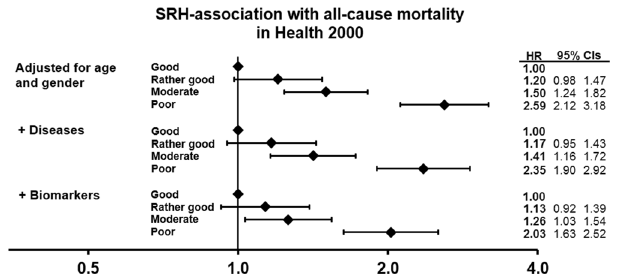
Figure 3. Association of self-rated health with mortality in the Health 2000 data (n = 5,957; deceased n = 1,207; 15-year follow-up). In Cox proportional hazards models (iii) hazard ratios (HRs) and 95% CIs were adjusted for (1) age and gender; (2) then additionally for number of diseases; and then (3) additionally for 10